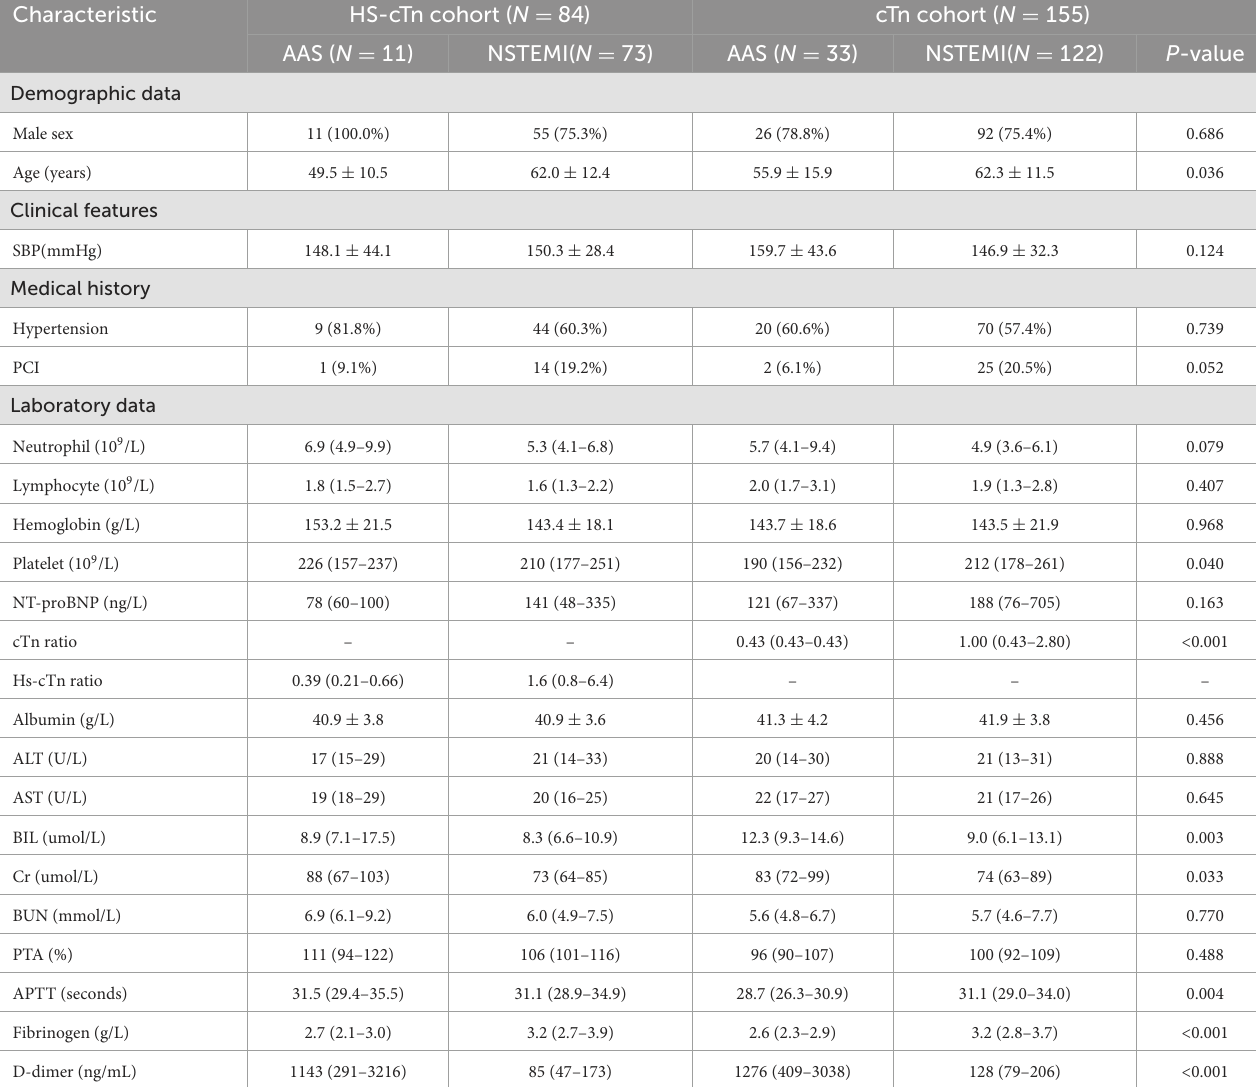
TABLE 1 Baseline characteristics of AAS vs . NSTEMI with chest pain onset < 2 h.